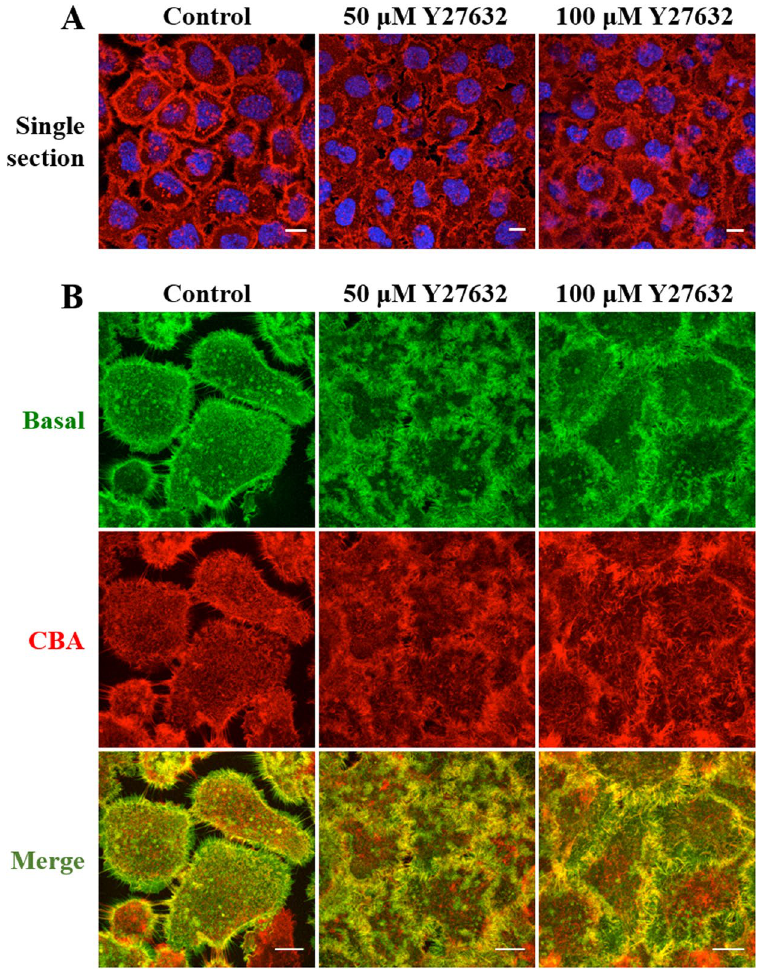
Figure 7. Effects of Y27632 on the actin architecture of A431 cells. Cells on coverslips were treated either with diluent control (D-MEM) or 50, 100 μ M of Y27632 for 4 hr before fixing and staining with Rh-P and Hoechst. ( A ) Single sections show the overall distribution of the actin relative to the nucleus. ( B ) Actin arrangement from the basal, CBA regions and composite (Merge) of basal and CBA. Scale bars 10 μ